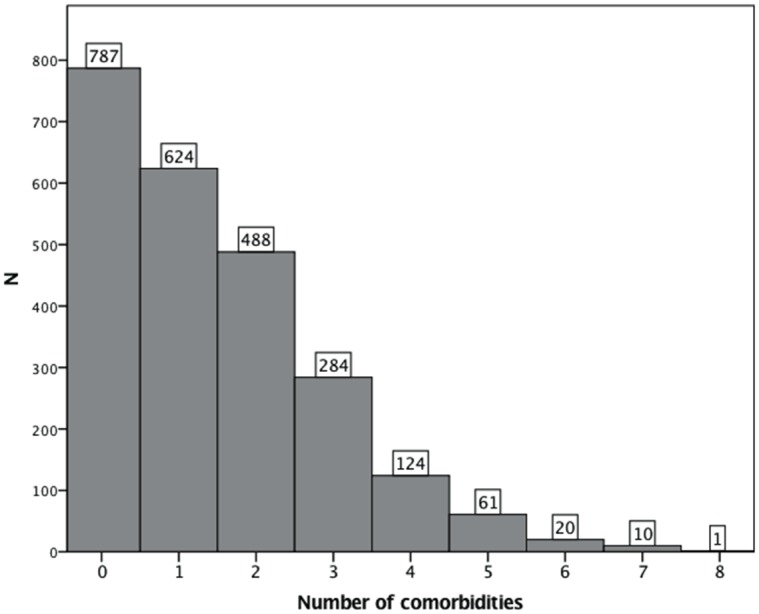
Frequency of comorbidities.